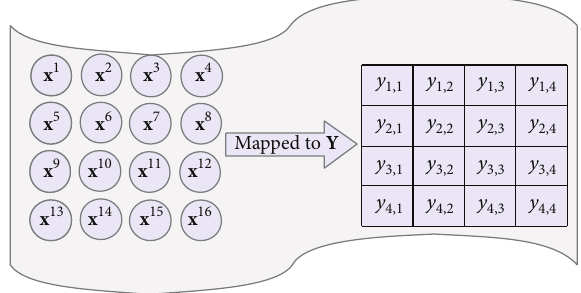
Figure 4: The individuals of HM mapped into the toroidal mesh Y.